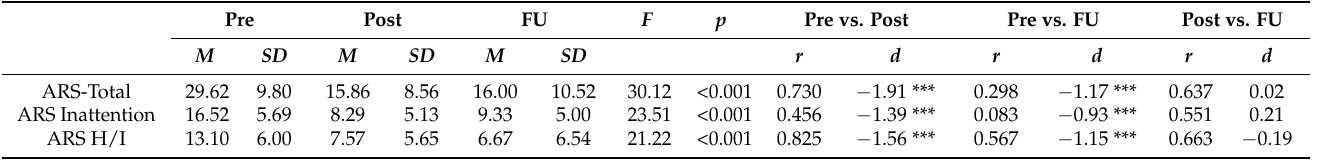
Table 4. Means, standard deviations, repeated-measures analyses of variance, and post hoc compar- isons with effect sizes for the scales of the primary outcome measure ADHD Rating Scale ( n =